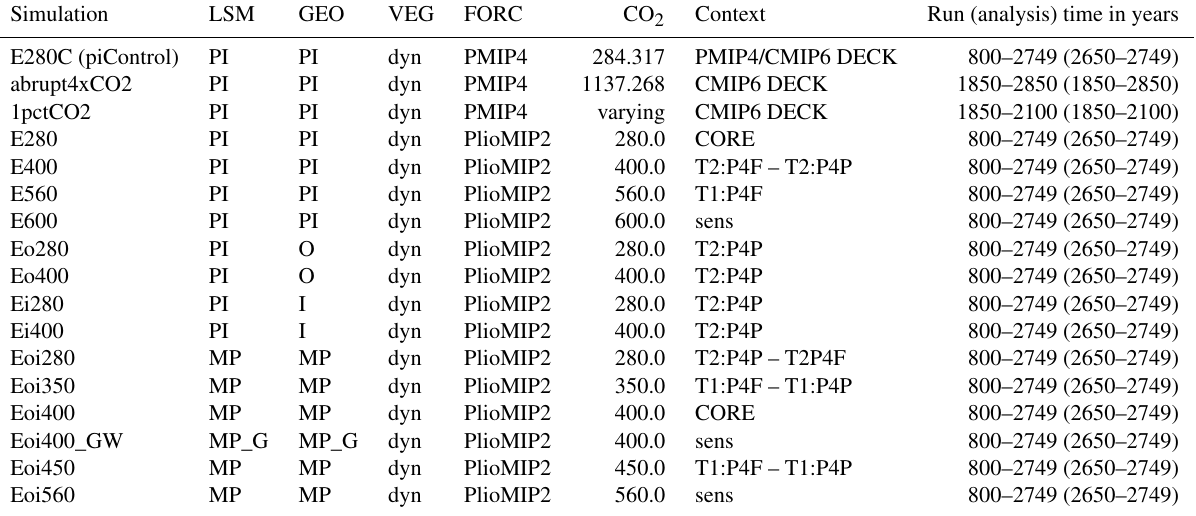
Table 1. Simulations prepared with COSMOS in the framework of PlioMIP2. COSMOS setups are based on pre-industrial (modern) bound- ary conditions (PI), implementation of mid-Pliocene paleogeography in COSMOS (MP), or on a mixed setup of modern geography with mid-Pliocene ice sheets (I), mid-Pliocene geography with modern ice sheets (O), or mid-Pliocene geography with modern ocean gateways (MP_G). Mid-Pliocene land–sea mask (LSM) and geography (GEO) are as provided by PRISM4 (Dowsett et al., 2016). Vegetation (VEG) is always computed dynamically (dyn). Context of a specific simulation (Haywood et al., 2016): PlioMIP2 core simulation (CORE); PlioMIP2 Tier 1 simulation (T1); PlioMIP2 Tier 2 simulation (T2); Pliocene4Future (P4F), Pliocene4Pliocene (P4P). The total run time of a simulation is given from initial year to end year, and the PlioMIP2 analysis period is given in brackets. We present simulations beyond the official curriculum of PlioMIP2: additional sensitivity (sens), CMIP6 DECK, and PMIP4. Carbon dioxide (CO 2 in parts per million by volume – ppmv) is specified explicitly; other forcings (FORC) are per the specifications of methane (CH 4 ) and nitrous oxide (N 2 O) in parts per billion by volume (ppbv), eccentricity of the Earth orbit (ecc), obliquity of the Earth axis (obl), and longitude of perihelion (lonp). PlioMIP2